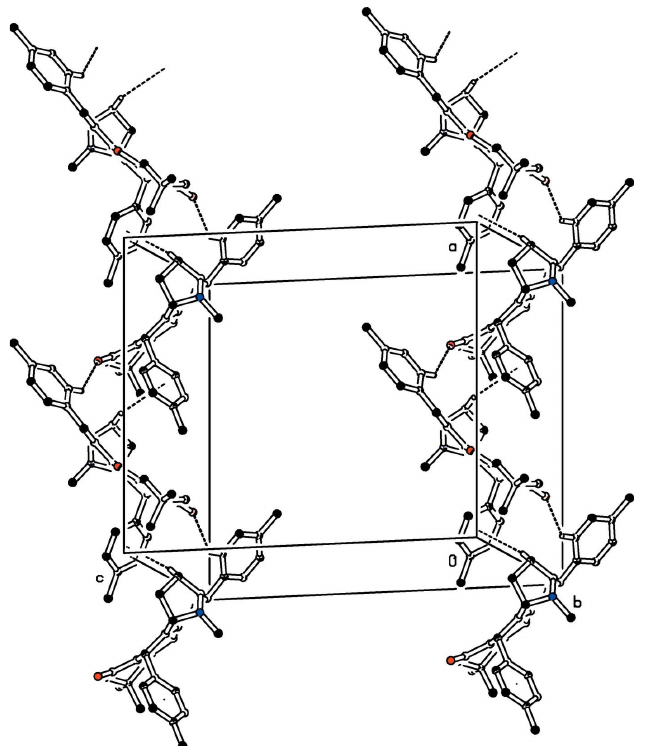
Figure 4 The crystal packing of the title compound (I) viewed along b axis. The C—H (cid:2)(cid:2)(cid:2) O and C—H (cid:2)(cid:2)(cid:2) (cid:2) intermolecular interactions are shown as dashed lines. For clarity, H atoms not involved in these interactions have been